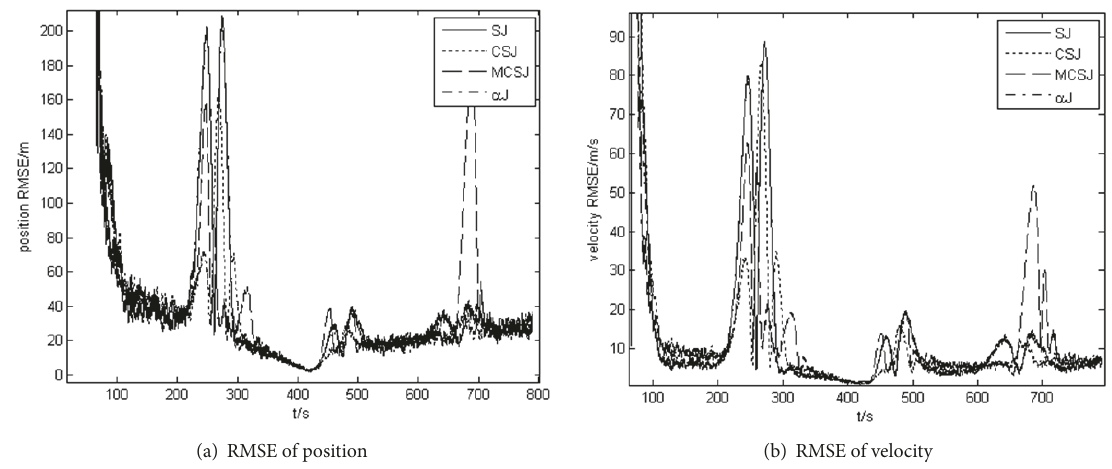
Figure 4: Filtering RMSE for four models in P3